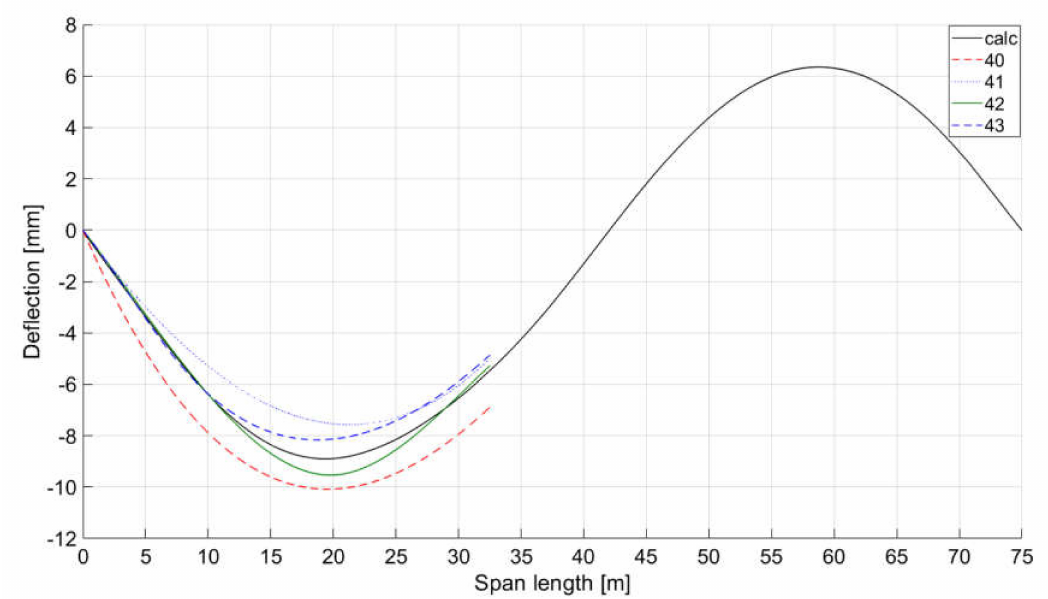
Figure 8. Analysis of the sensitivity to measurement errors of the structure quasi-static deflection mapping using spline curves in relation to the deflection curve determined with the use of numerical model load data (calc); 40—deflection curve determined by a single 3 ◦ curve, 41—line determined by a single 3 ◦ curve with an angle of rotation at support equal to that of inclinometer I1, 42—line determined by 2 spline curves with an angle of rotation at support equal to that of inclinometer I1, 43—line determined by 3 spline curves with an angle of rotation at support equal to that of inclinometer